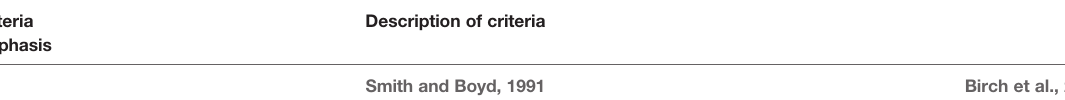
TABLE 5 | Examples of frameworks used to evaluate scienti fi c evidence of sentience in